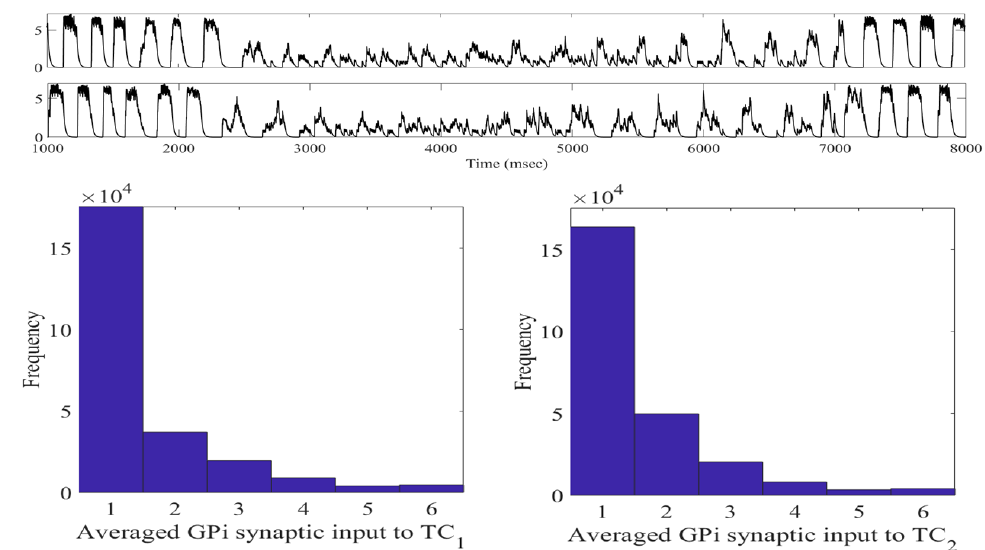
Figure 12. Total GPi synaptic inputs sg 1 and sg 2 ( top traces ) with corresponding histograms of sg ( left ) and sg ( right ) during the treatment window when aLFPDBS was applied with a 0 = 6 and 2 intt = 300.